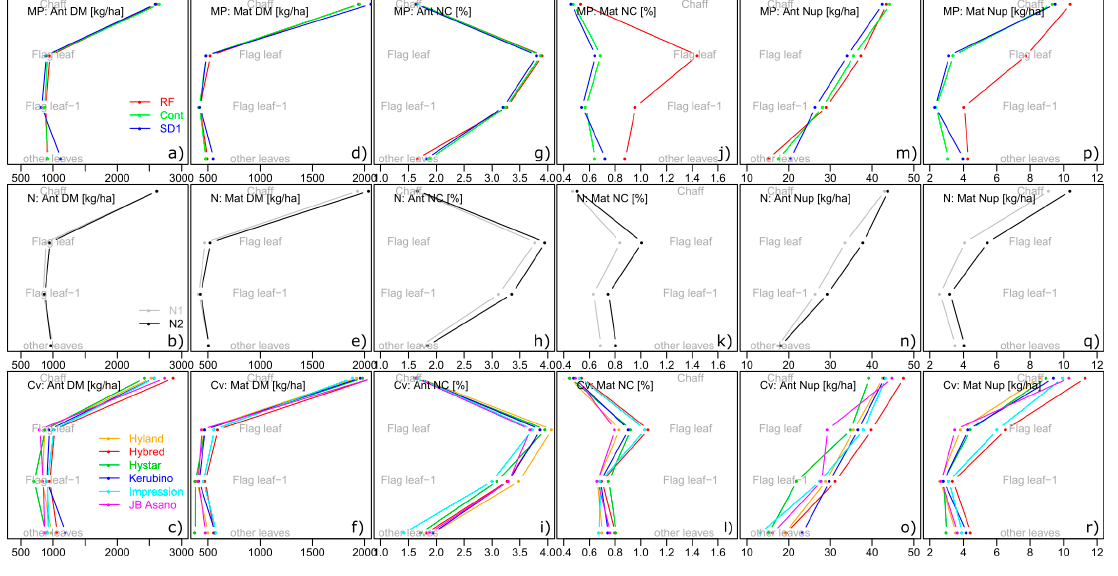
Figure 9. Vertical distribution of dry matter (DM, a – f ), N concentration (NC, g – l ) and N uptake